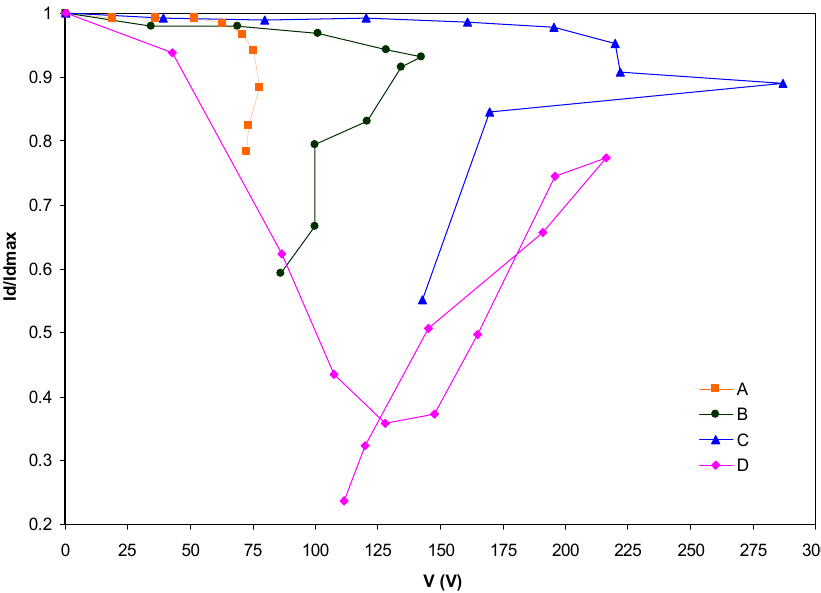
Figure 4. Diffracted light intensity divided by the maximum diffracted light intensity versus voltage.